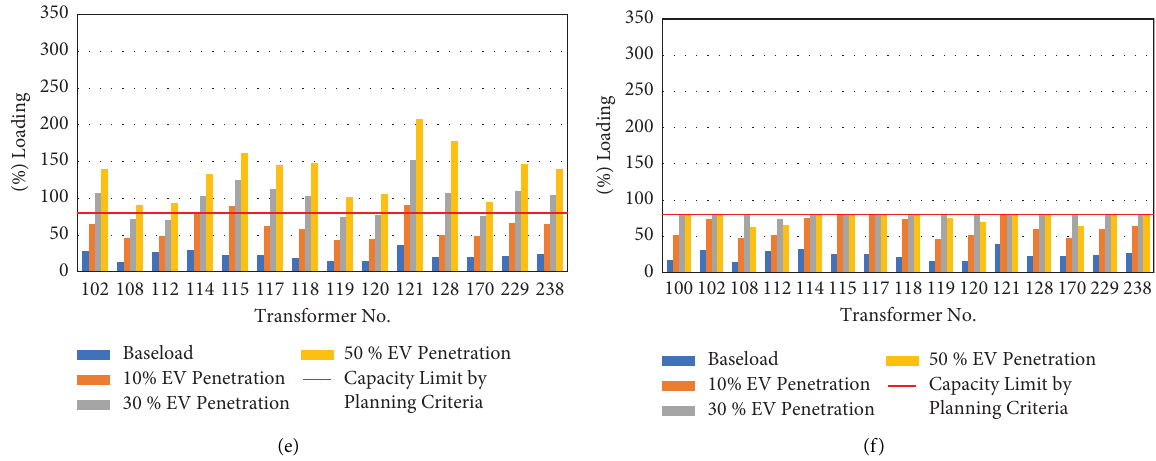
Figure 13: Comparison of percent loading of distribution transformers under primary feeder no. 5 with the three scenarios of EV penetration between uncoordinated and smart charging. (a, c, e) uncoordinated charging; (b, d, f) smart